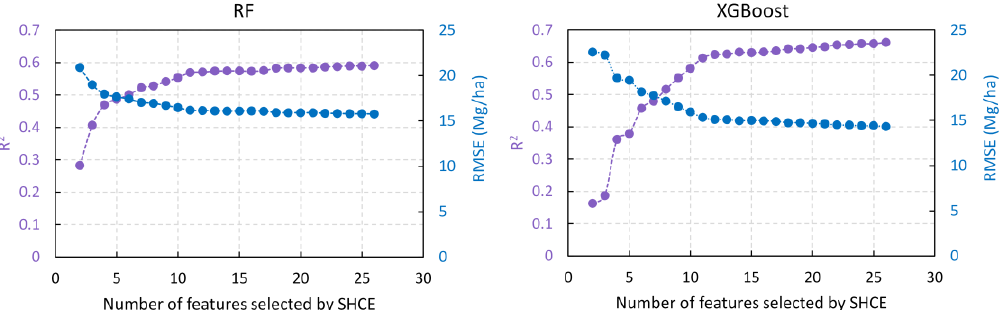
Figure 9. Prediction accuracy using different numbers of important predictors selected by the proposed SHCE algorithm.